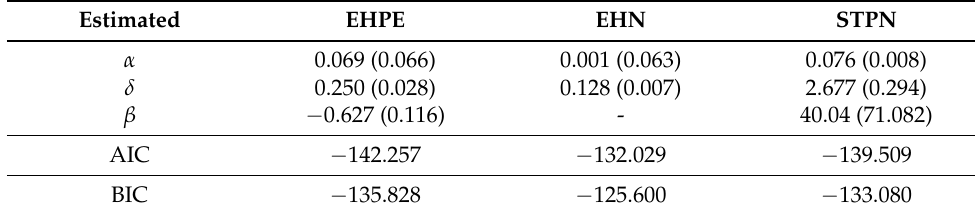
Table 5. Estimated parameters and their standard errors (in parentheses) for the EHPE.